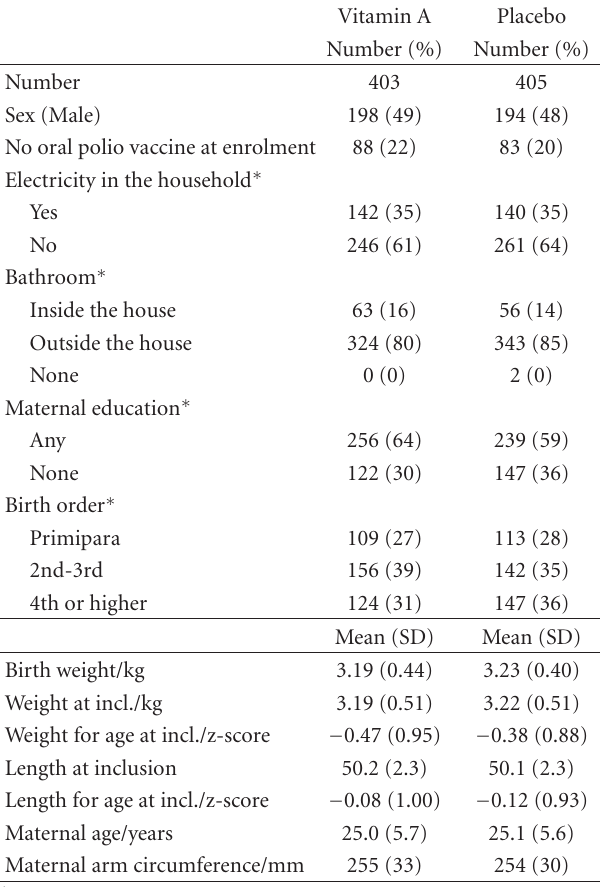
Table 1: Baseline characteristics of all children included in the growth cohort by randomisation